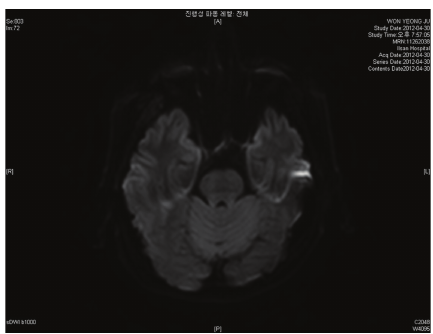
Figure 3: Di ff usion-weighted MR image of the patient after neu- rological symptoms improved. Lack of di ff usion restriction around the right cavernous sinus indicates that there is no residual infec- tious